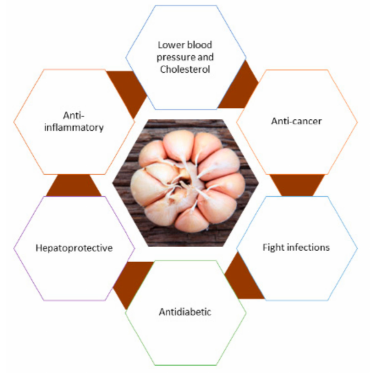
Figure 2. Overall beneficial e ff ects of